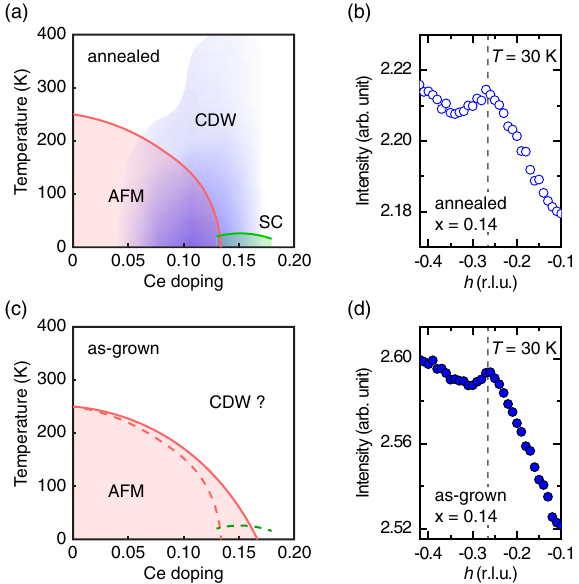
FIG. 1. Phase diagram of annealed and as-grown NCCO and their RSXS measurements. Phase diagram of the (a) annealed and (b) as-grown NCCO as a function of Ce doping. The red, green, and blue areas denote the long-range AFM order, SC, and the proposed CDW, respectively. Dashed lines in panel (c) denote AFM and SC boundaries after annealing as displayed in panel (a). RSXS data of the (b) annealed and (d) as-grown NCCO ( x ¼ 0 . 14 ). These were measured at the Cu L 3 edge (931 eV) with T ¼ 30 K. The vertical lines indicate the peak position at h ¼ − 0 . 26 (cid:3) 0 . 01 reciprocal lattice units